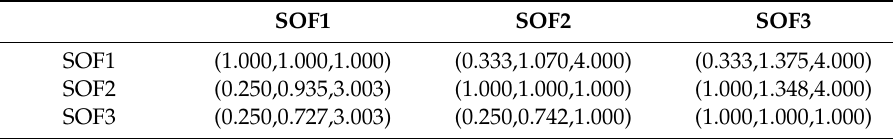
Table A8. Fuzzy pairwise comparison with respect to social criteria